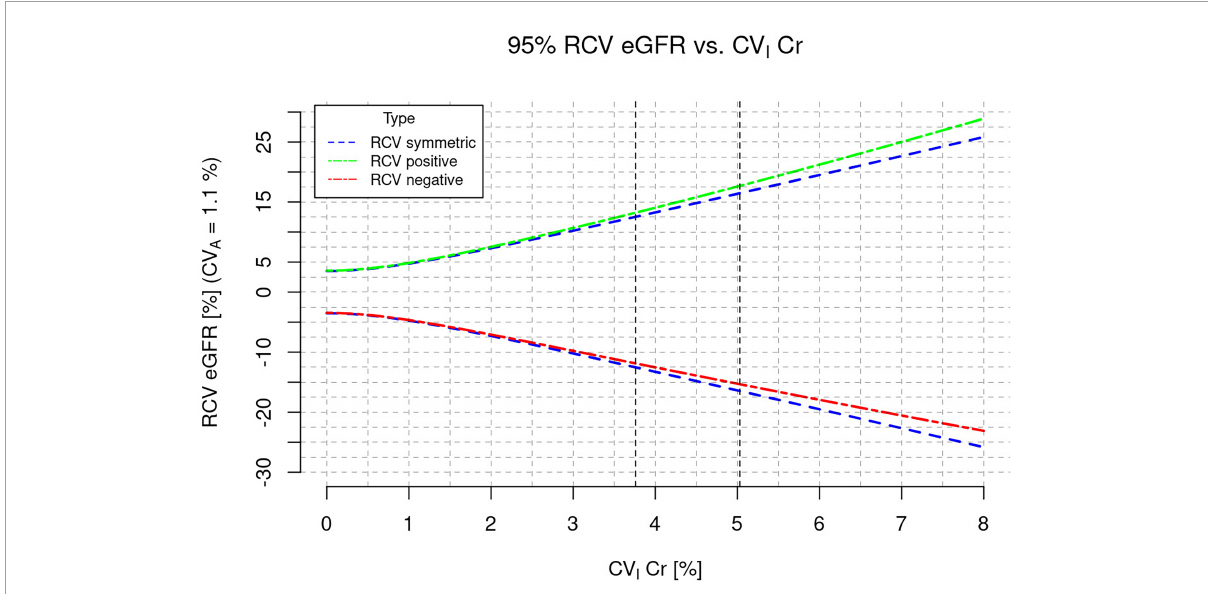
FIGURE3 Reference change value (RCV) of estimated glomerular filtration rate (eGFR) as a function of CV I of creatinine.